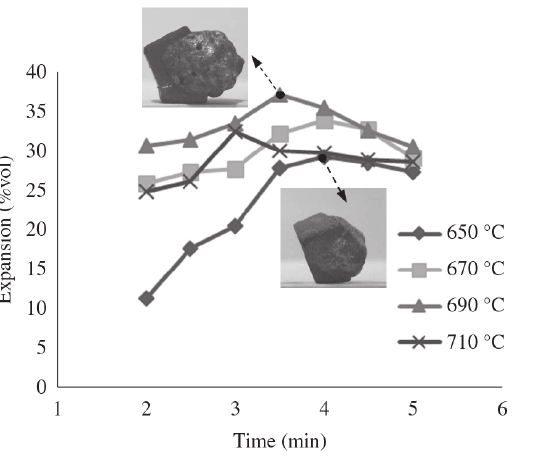
Figure 6. Expansion rates of 70% deformed samples at various foaming